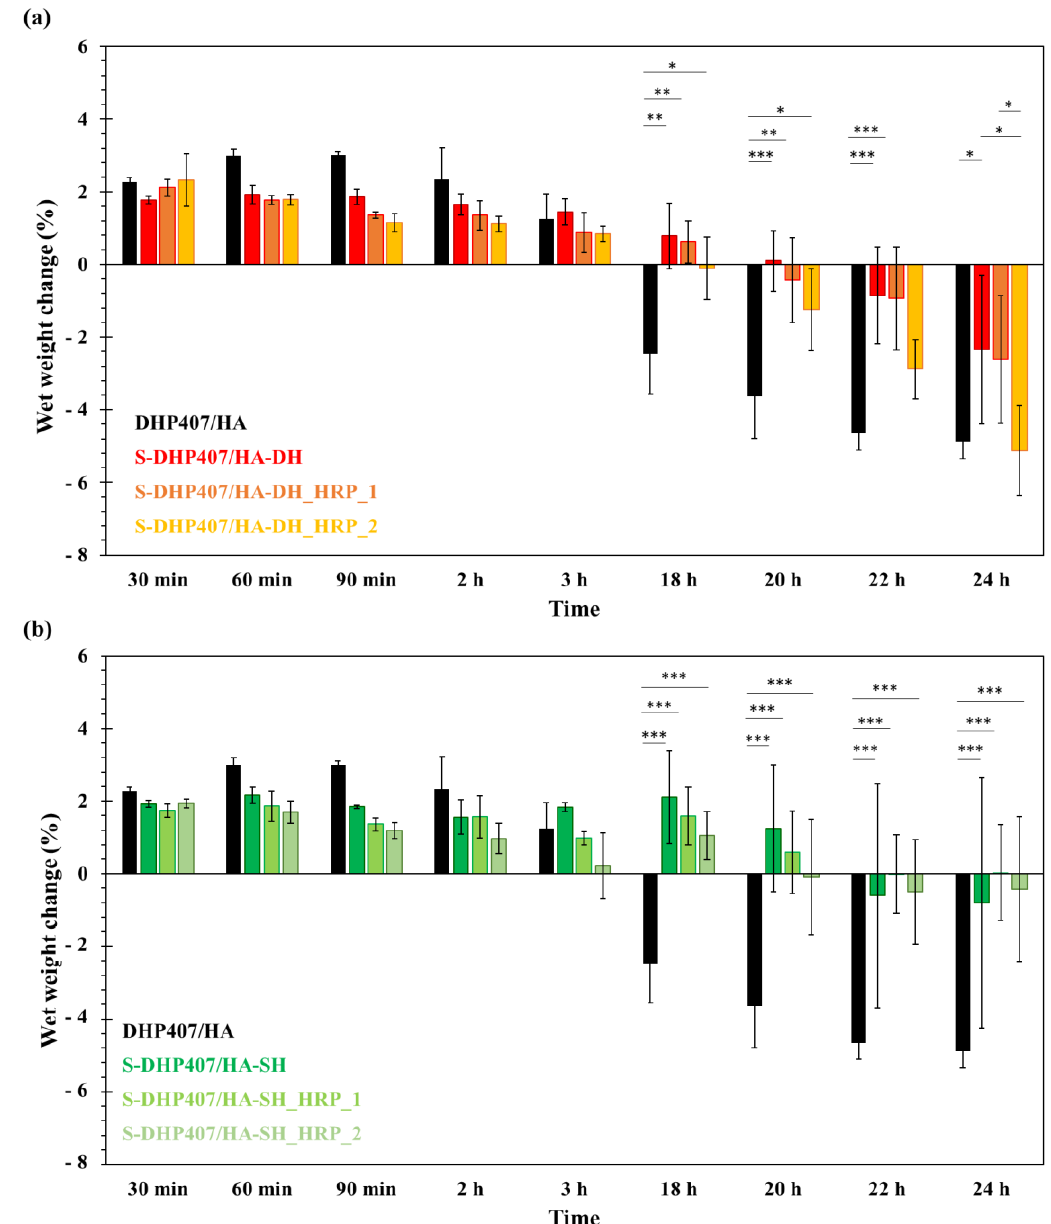
Figure 10. Percentage of wet weight change as measured for the developed bioartificial formulations and control samples during incubation in contact with PBS (pH 7.4) at 37 °C. ( a ) Stability of DHP407/HA (black) and HA-DH-based blends with S-DHP407 (i.e., S-DHP407/HA-DH, S- DHP407/HA-DH_HRP_1 and S-DHP407/HA-DH_HRP_2); ( b ) Stability of DHP407/HA (black) and HA-SH-based blends with S-DHP407 (i.e., S-DHP407/HA-SH, S-DHP407/HA-SH_HRP_1 and S- DHP407/HA-SH_HRP_2). (* p < 0.05, ** p < 0.02, *** p < 0.001).